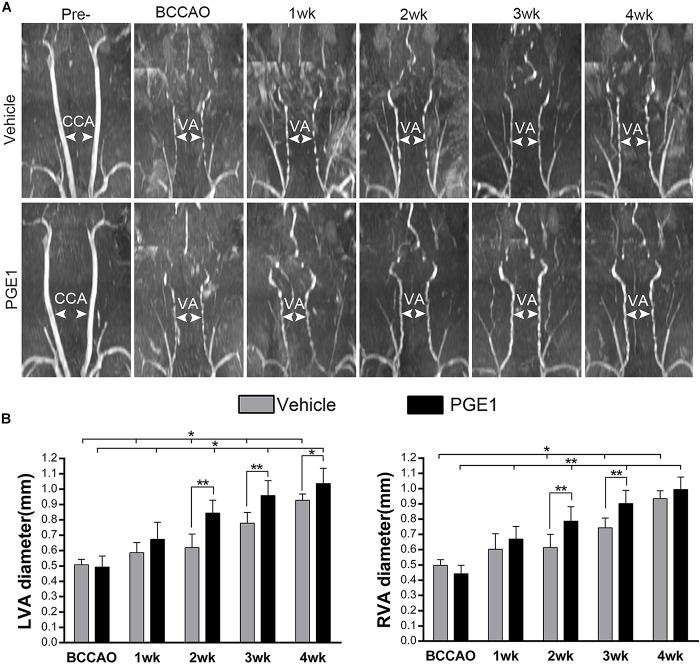
PGE1 treatment promotes vasodilation in the vertebral arteries. (A) MRI 3D-TOF angiography was used to capture the morphological changes and diameter of the vertebral arteries (VAs) in the vehicle- and PGE1-treated groups following BCCAO. Common carotid arteries (CCAs) and VAs were indicated by white arrowheads. (B) Quantitative analysis showing changes in left (L) and right (R) VA diameter from 1 to 4 weeks in the vehicle- and PGE1-treated groups. Data are presented as mean ± SD; n = 8. ∗∗p < 0.01, ∗p < 0.05.